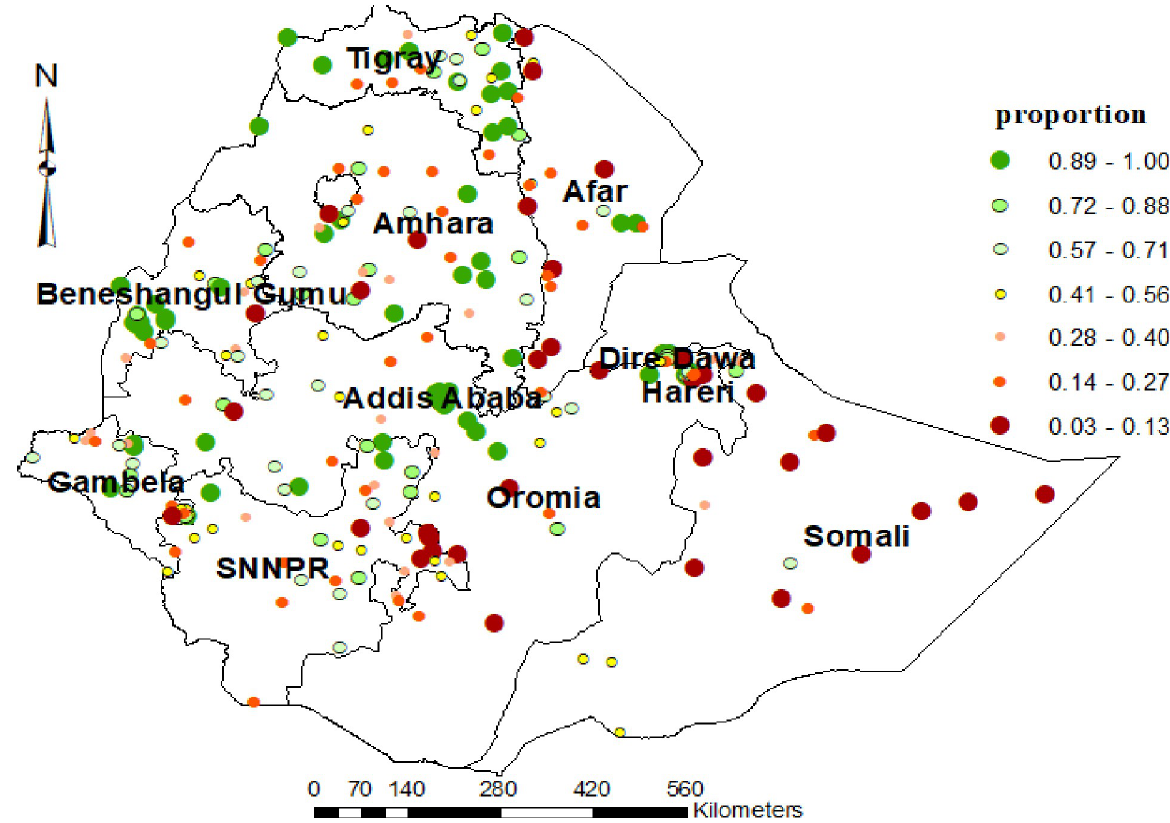
Fig 2. Hot spots analysis of institutional delivery among women who had live birth in the last five years preceding 2019 EDHS.